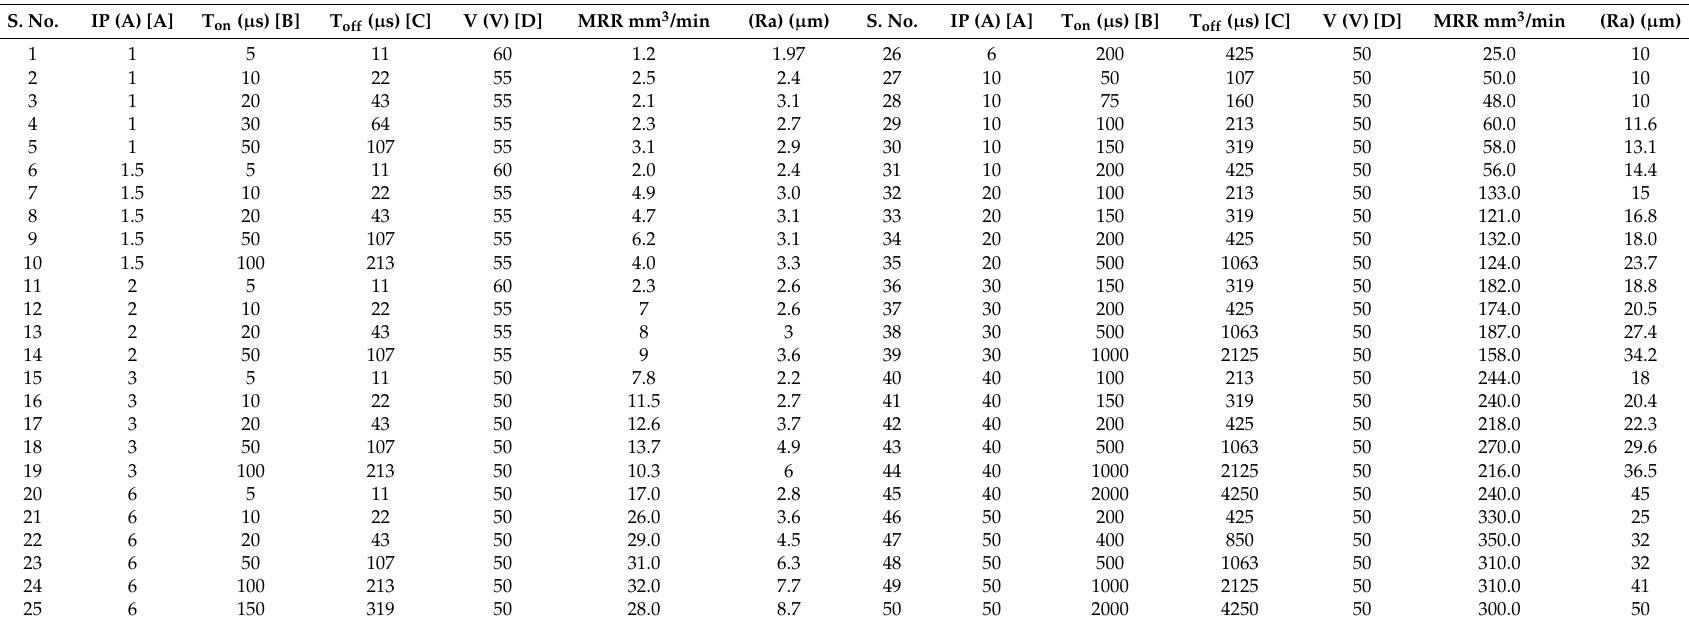
Table 5. Experimental observation for material removal rate (MRR) and roughness parameter